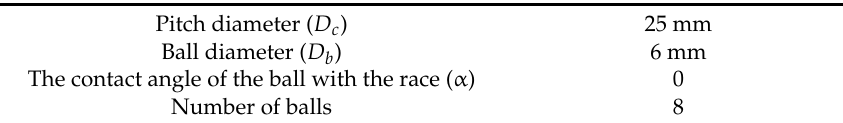
Table 2. Specifications of